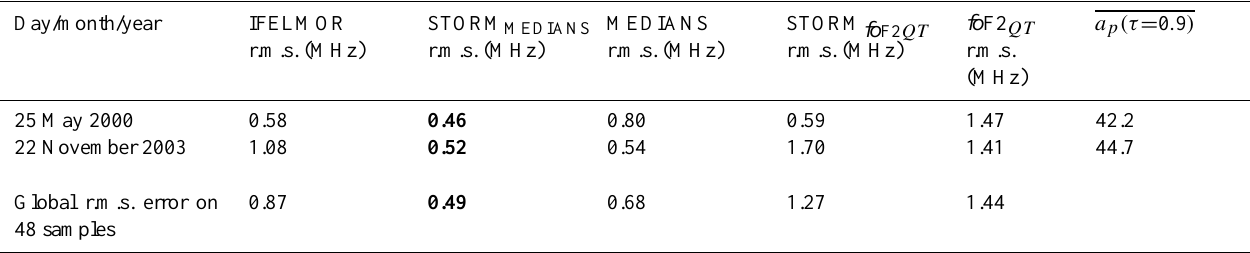
Table 3. Comparisons in terms of r.m.s. for the days selected under disturbed ionospheric conditions with a p (τ = 0 . 9 ) ≤ 50; the best perfor- mance is labelled in